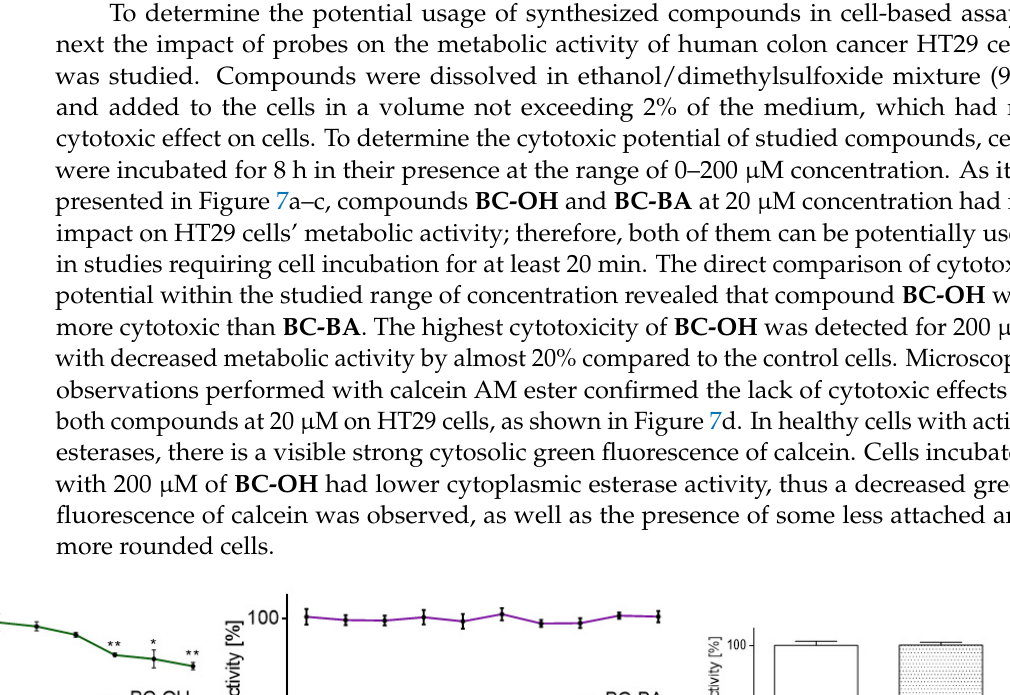
Figure 7. The influence of BC-OH ( a ) and BC-BA ( b ) on HT29 cell metabolic activity, determined by MTT assay after 8 h exposure; control cells were not exposed to any compound but the vehicle (EtOH/DMSO (9:1) ( c ); values are means ± SEM, n ≥ 7; statistical significance was calculated versus control cells (untreated), * p ≤ 0.05, ** p ≤ 0.01. Morphology of HT29 cells stained with 2 µM calcein AM observed after incubation with 20 and 200 µM of BC-OH and BC-BA ( d ); randomly chosen fields were photographed at × 200 with fluorescent microscope Nikon TS Eclipse 100. 3. Materials and Methods 3.1. General The reagents used for the synthesis were commercially available. 3-benzothiazol-2- yl-7-hydroxy-chromen-2-one ( BC-OH ) and 3-benzothiazol-2-yl-chromen-2-one ( BC-H ) were synthesized according to published protocols [32,38]. The purity of the final compounds was tested by HPLC (Shimadzu) equipped with a photodiode array detector and analytical column—Phenomenex Kinetex Core-Shell C18 (100 mm × 4.6 mm; 2.6 µm). The mobile phase was a gradient prepared from acetonitrile with 0.1% of TFA (component A) and water with 0.1% of TFA (component B). The analytes were eluted by an increase of A concentration from 10–100% over 10 min at the flow rate of 1.5 mL/min. The column temperature was set at 30 °C. 1 H NMR spectra were recorded with a Bruker Avance DPX 250 spectrometer at 250 MHz, respectively (see supplementary materials). Compounds were dissolved in DMSO- d 6 and TMS was added as internal reference. Mass spectra [TOF MS (ESI+)] were recorded on a Synapt G2-Si spectrometer (Waters, Milford, MA, USA).